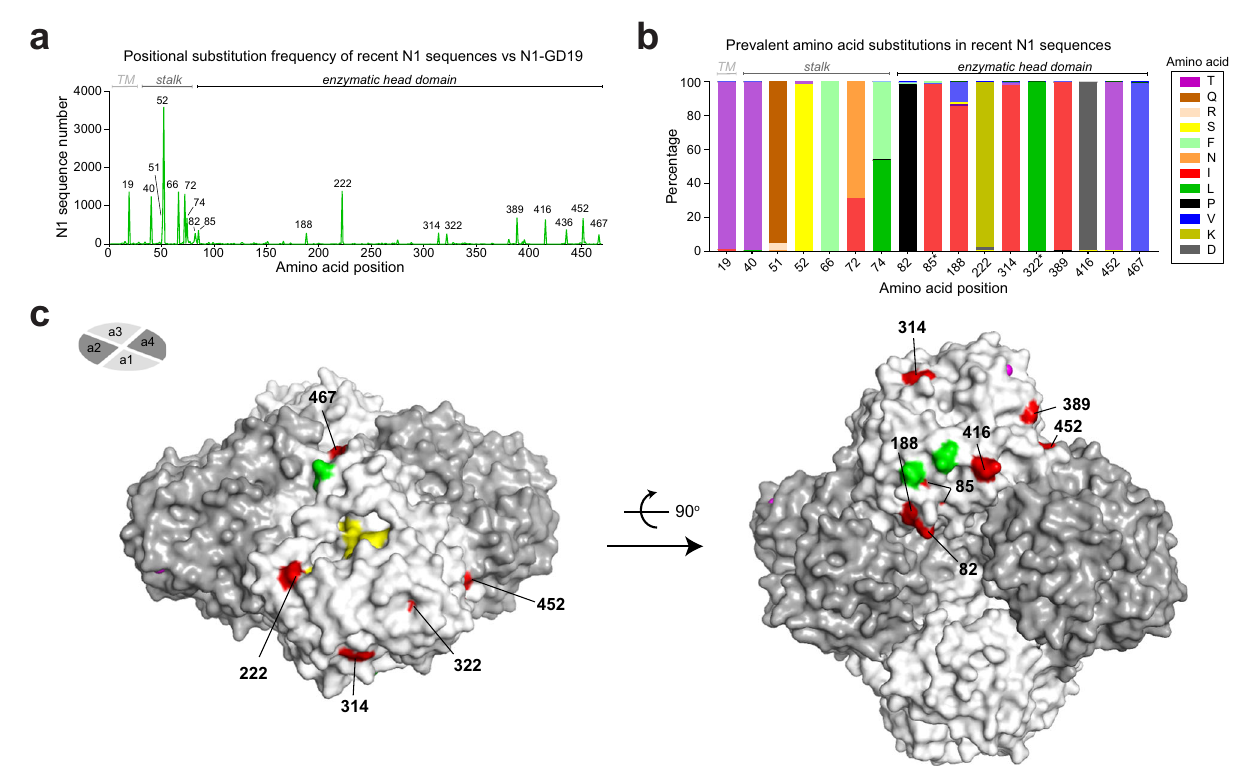
Fig. 4 Comparison of NAs from recent H1N1 viruses and the 2020 – 2021 vaccine strain. a Amino acid positional analysis displaying the number of recent N1 sequences that encode different amino acids from N1-GD19 at each position. N1 sequences were from human H1N1 IAVs collected between September 1, 2019 and December 15, 2020. Regions corresponding to the transmembrane (TM) domain, stalk and enzymatic head domain are indicated. b Bar graph displaying the prevalence of the amino acids in the recent N1 sequences that differ from N1-GD19 at each position. Only amino acids visible in the graph are listed in the legend. Asterisk indicates amino acids with little surface exposure. c Amino acid positions that differ in the recent N1 sequences are highlighted (red) on a single monomer of a head domain tetramer (PDB ID: 3NSS) 54 along with the Asn residues (green) of the conserved N-linked glycosylation sites 48 , NA active site residues (yellow), and Ca 2 + ions (pink). Side (left) and bottom (right) views of the NA tetramer were generated using Pymol.